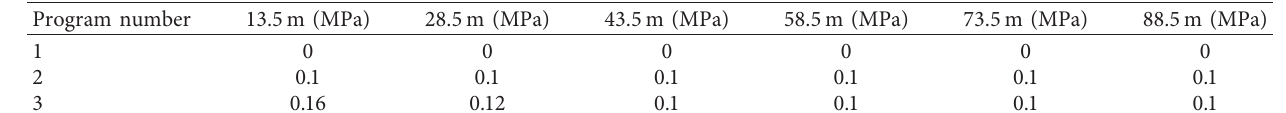
Table 9: Different grouting pressure program configuration of case B1.